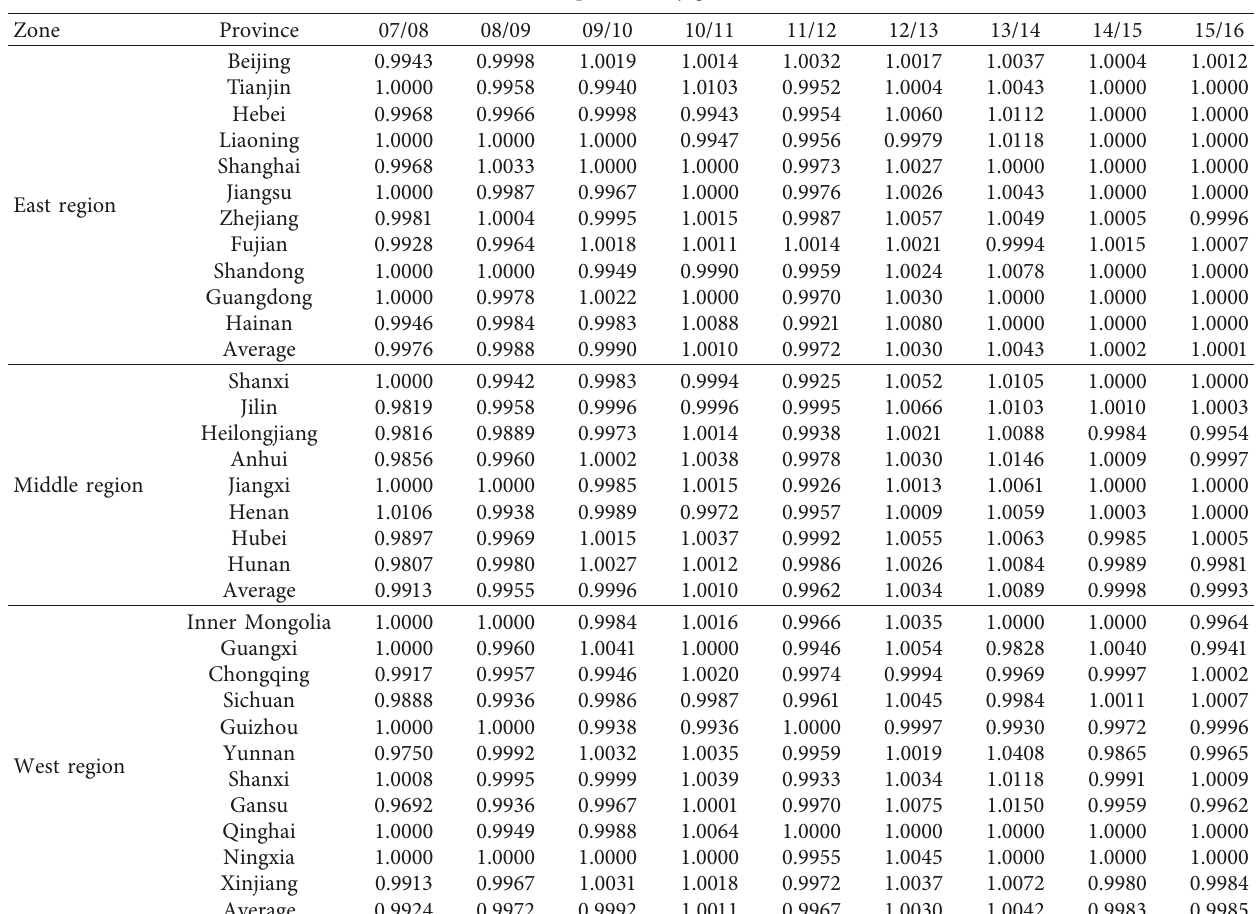
Table 2: Green total factor productivity growth ratio in